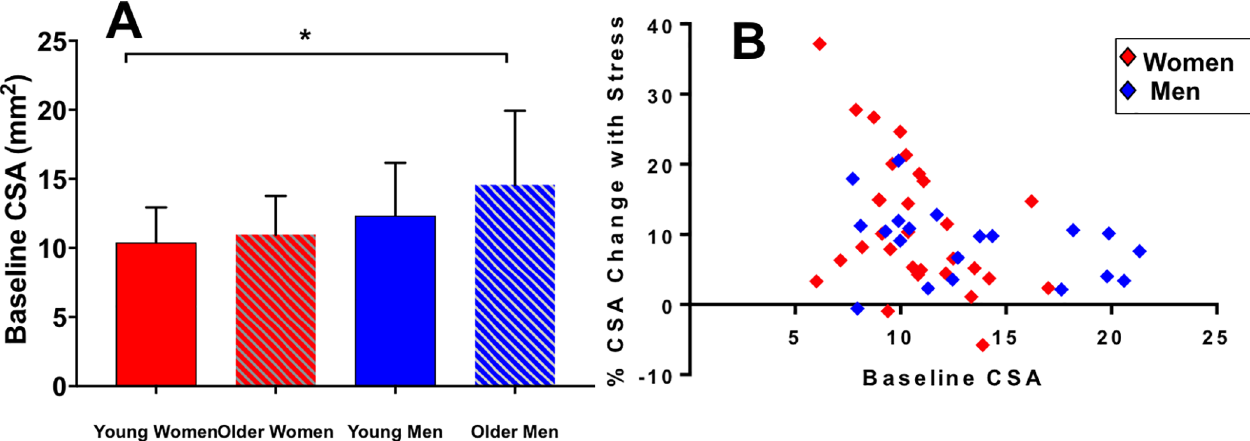
Fig 3. Baselinecoronarycross sectionalarea. (A) Summary data for baselineCSA (coronarycross sectional area), showingmean +/- SD (error bars) for four groups: youngerwomen, older women, youngermen and older men. The baselineCSA is higherin older men compared to younger women ( * p = 0.01). Correlationof baselinecross sectionalarea with percent change in cross sectionalarea by sex (B) There was no significant relationshipbetweenbaselineCSA and % CSA change for women (red diamonds) and men (blue diamonds).